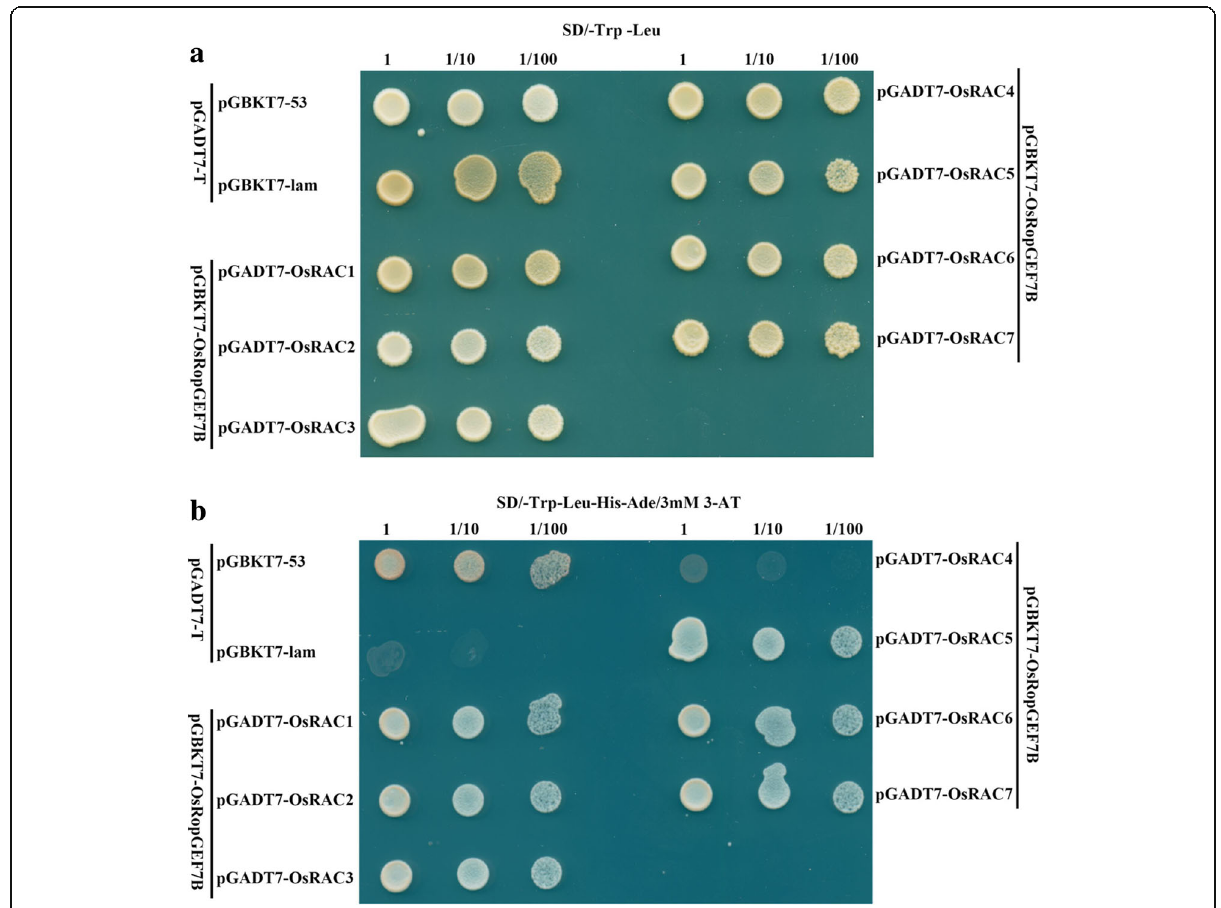
Fig. 7 Interactions between OsRopGEF7B and OsRACs in the Y2H assay. The transformants were plated onto ( a ) double dropout medium (SD/ − Trp/ − Leu) and onto ( b ) quadruple dropout medium (SD/ − Trp/ − Leu/-His/ − Ade) supplemented with 3-AT. The pairs of pGBKT7 – 53 / pGADT7-T and pGBKT7-Lam / pGADT7-T were used as positive and negative controls, respectively. The growth of co-transformed yeast cells in the quadruple dropout medium supplemented with 3-AT is indicative of protein – protein interaction in